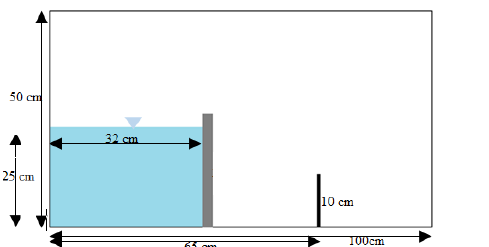
Figure 2 Initial geometry of sudden collapse of free water column (dam-break) in contrast to a rigid obstacle (dam-break) with initial height of 25 cm.